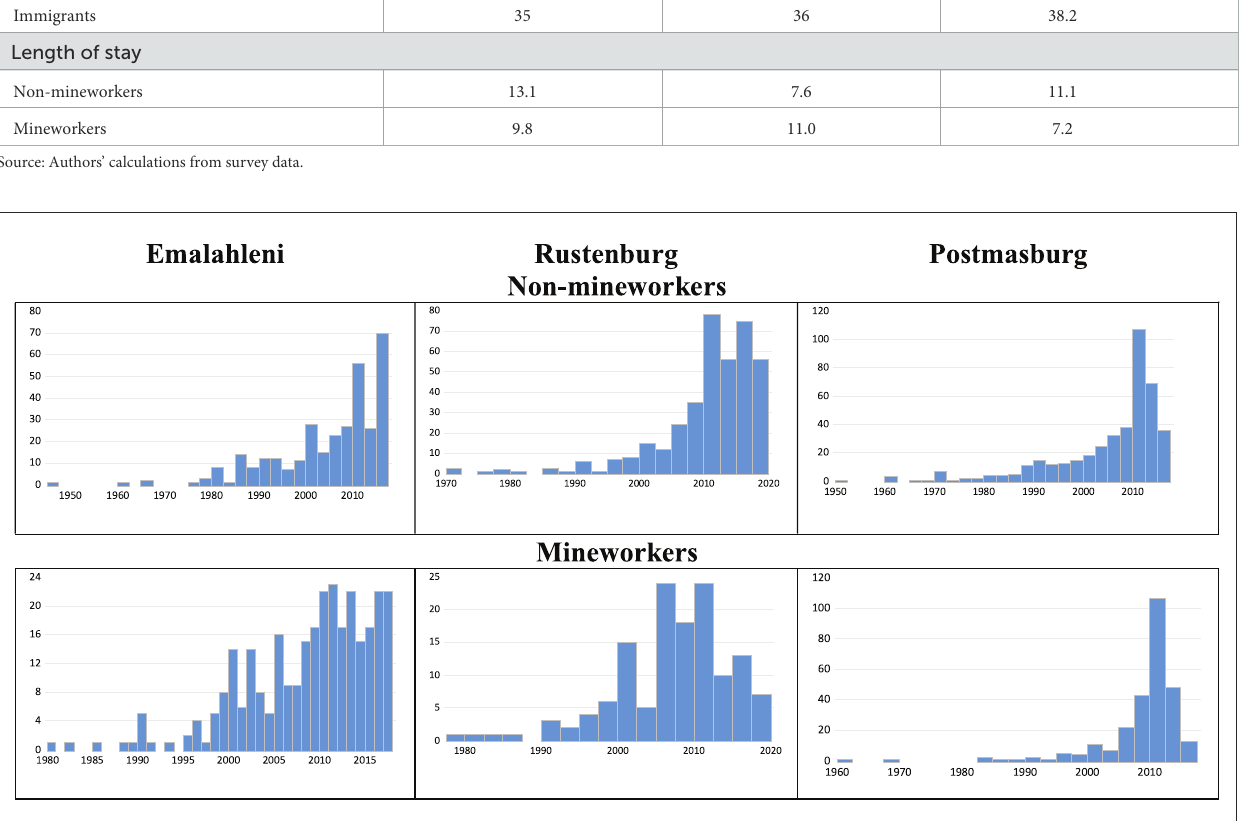
FIGURE2 New arrivals per year. Source: Authors’ own representation of survey data.